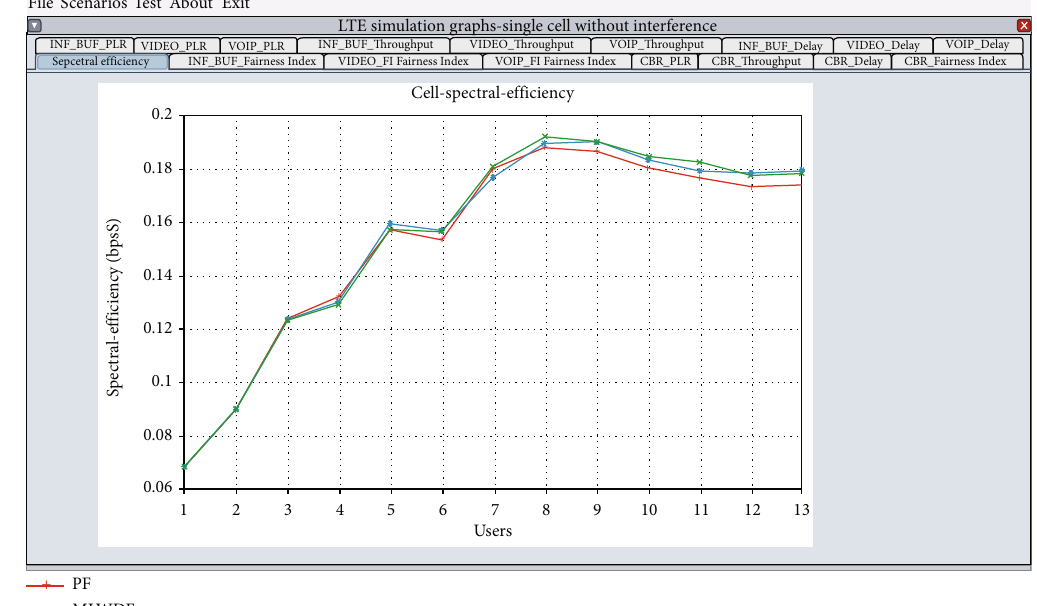
Figure 8: Spectral e ffi ciency vs. number of